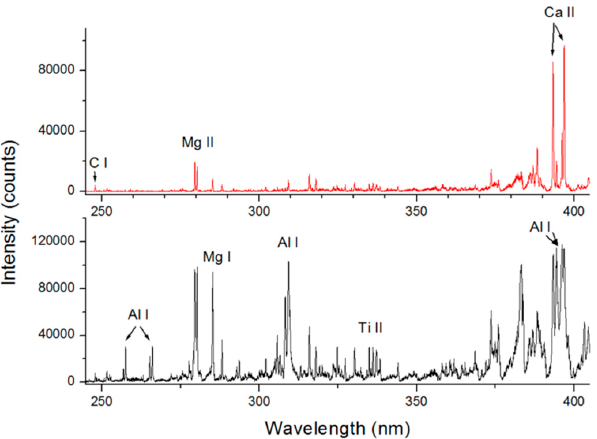
Figure 12. UV portion of a single-shot LIBS spectrum acquired at distance of 30 m on: top, Teflon substrate; bottom, aluminum target.